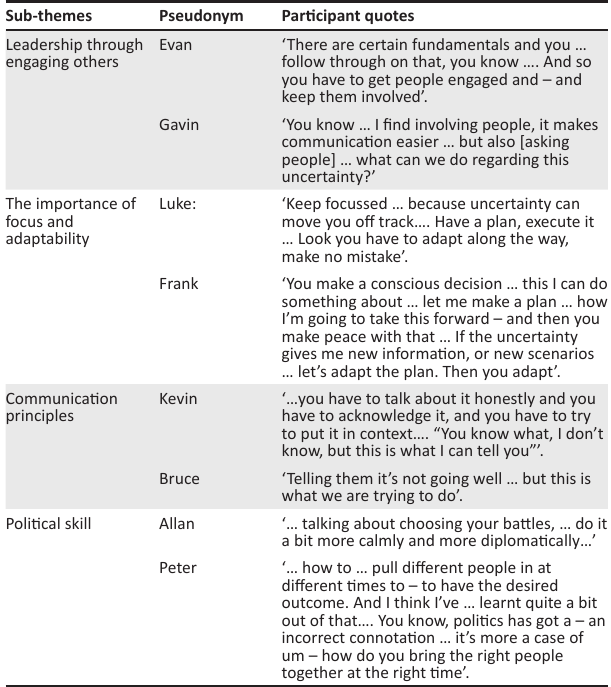
TABLE 5: Leadership approach during